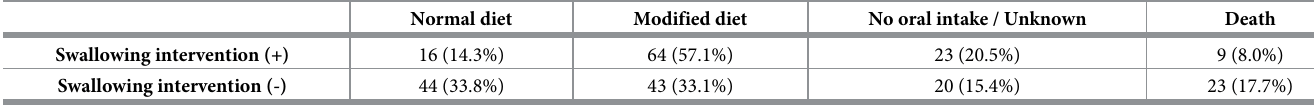
Table 5. The rate of normal diet intake in initially normal diet-taking aspiration pneumonia patients after swallowing interventions.